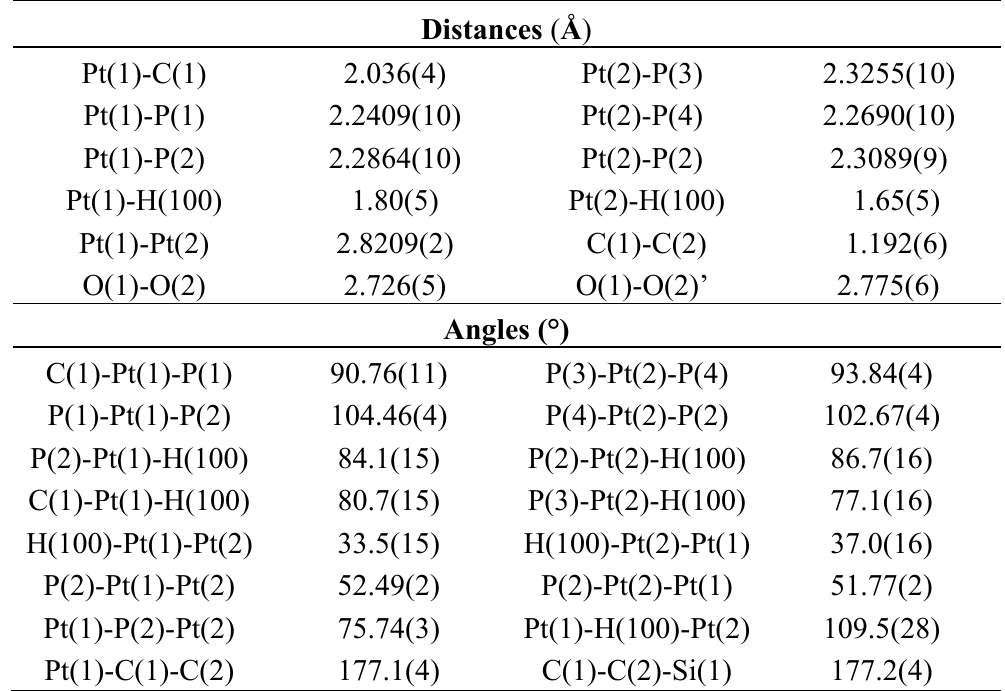
Figure 4. View of the molecular structure of 2 ·2 n -hexane·H 2 O; ( a ) the asymmetric unit showing the presence of the oxygen from the H 2 O and ( b ) the dimer generated